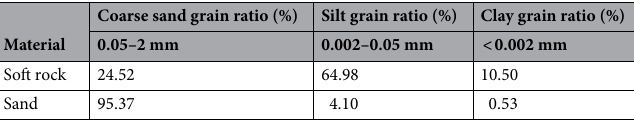
Table 1. Particle composition of soft rock and